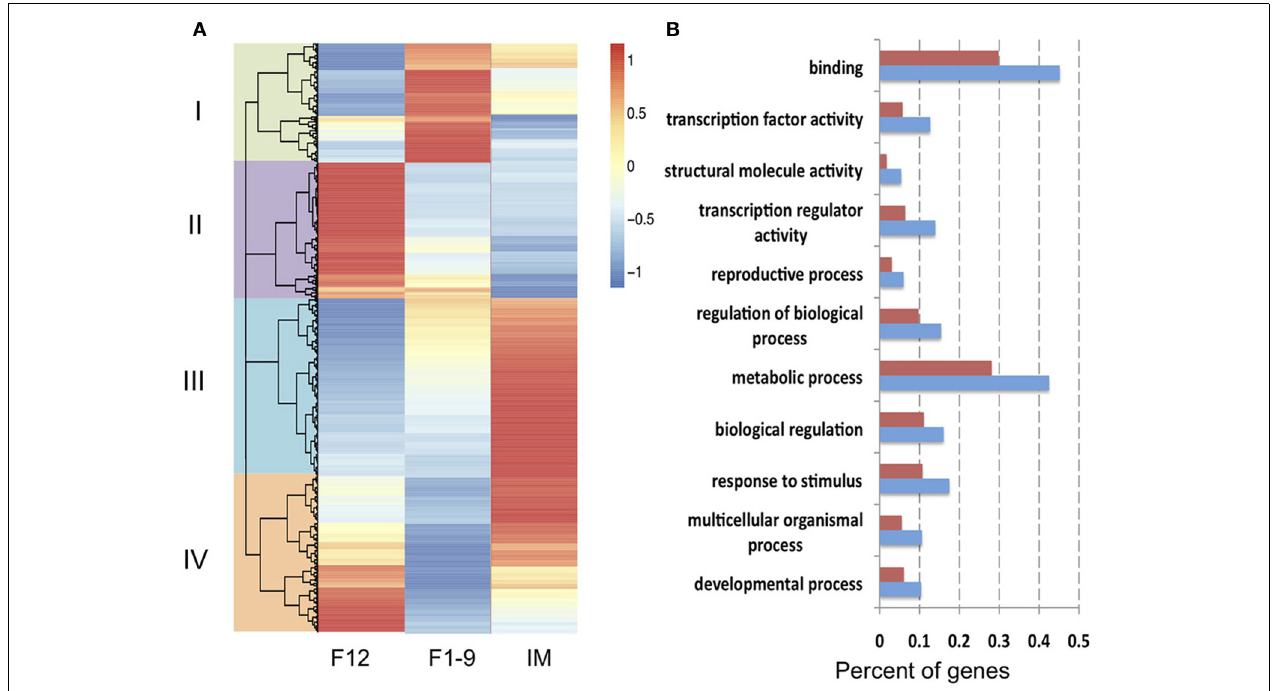
> F12), and 526 isoforms in cluster IV (the others). Genes expressed higher than average are colored in red while lower in blue. (B) A list of enriched GO terms for genes in Cluster III. Red bars represent ratio of total annotated genes for each function, blue bars for differentially expressed genes within cluster